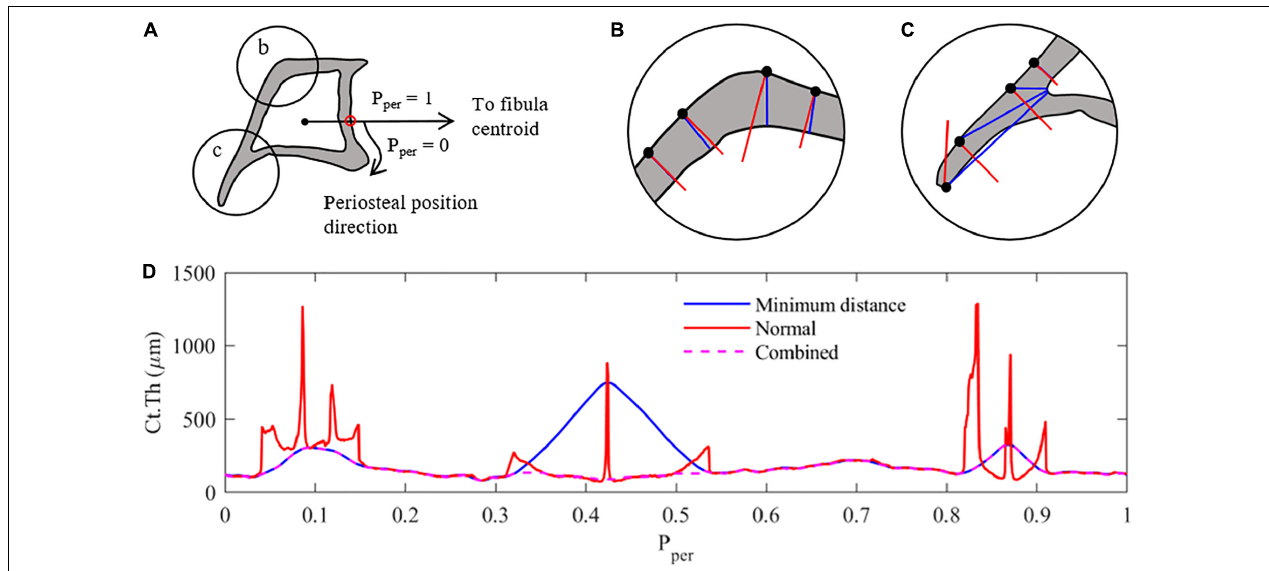
FIGURE 1 | Measurement methodology used to analyse the cortical thickness of mice tibia (z = 25% section). (A) Pre-processing – the cortical boundaries are located (periosteum and endosteum), and a characteristic periosteal point is determined as the intersection of a line connecting the centroids of the tibia and fibula (red dot). The periosteal length (perimeter) is normalised between 0 and 1. Ct.Th measurements at each periosteal point are taken clockwise around the tibial perimeter. (B) Thickness measurement case 1: minimum distance method (red) and surface-normal blue) measurements around the cortex. Similar results with minimum distance providing shorter measurements. (C) Thickness measurement case 2: thickness measurements along the tibial ridge, showing major differences between measurement methods with tangent-normal providing shorter measurements. (D) Combination of the two measurement methods, selecting the smallest distance determined by either measurement method, to create the most representative cortical thickness distribution of the tibial image. Combined Results are then filter using a 2nd order Butterworth